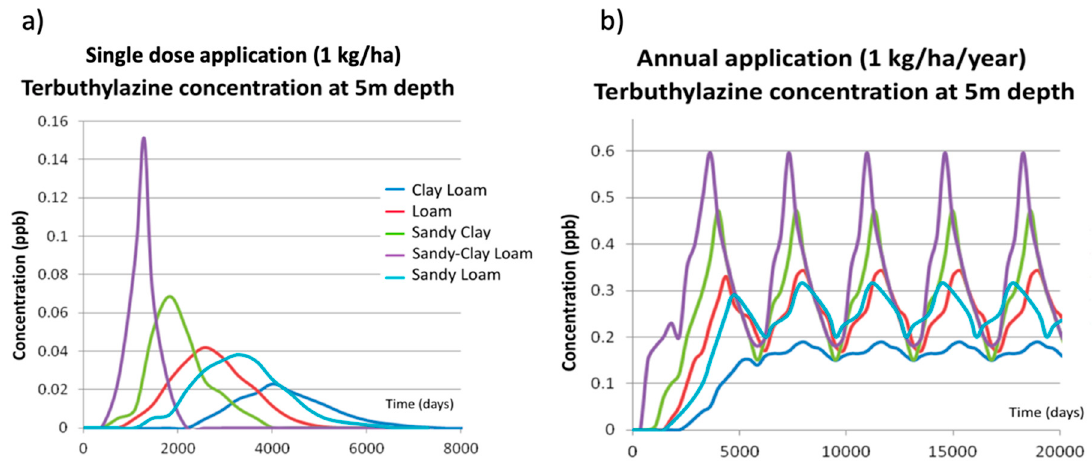
Figure 7. PRZM-GW terbuthylazine concentrations at 5 m depth for di ff erent types of soil. ( a ) Single dose application. ( b ) Annual dose application.